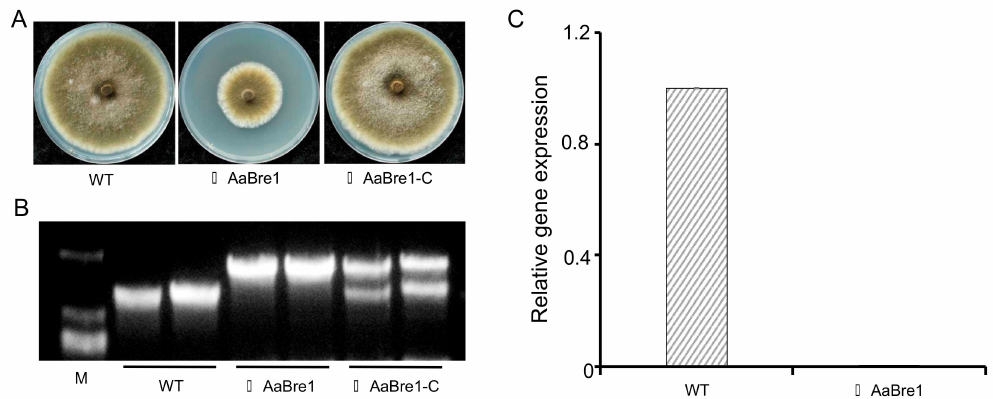
Figure 3. Characterization of ∆ AaBre1 and ∆ AaBre1-C strains. ( A ) Wild type (WT), ∆ AaBre1 and ∆ AaBre1-C were grown on PDA medium at 25 °C for seven days. ( B , C ) Molecular verification of the mutant strains, using ( B ) a gDNA-based PCR assay, ( C ) a quantitative real-time PCR (qRT-PCR) assay.